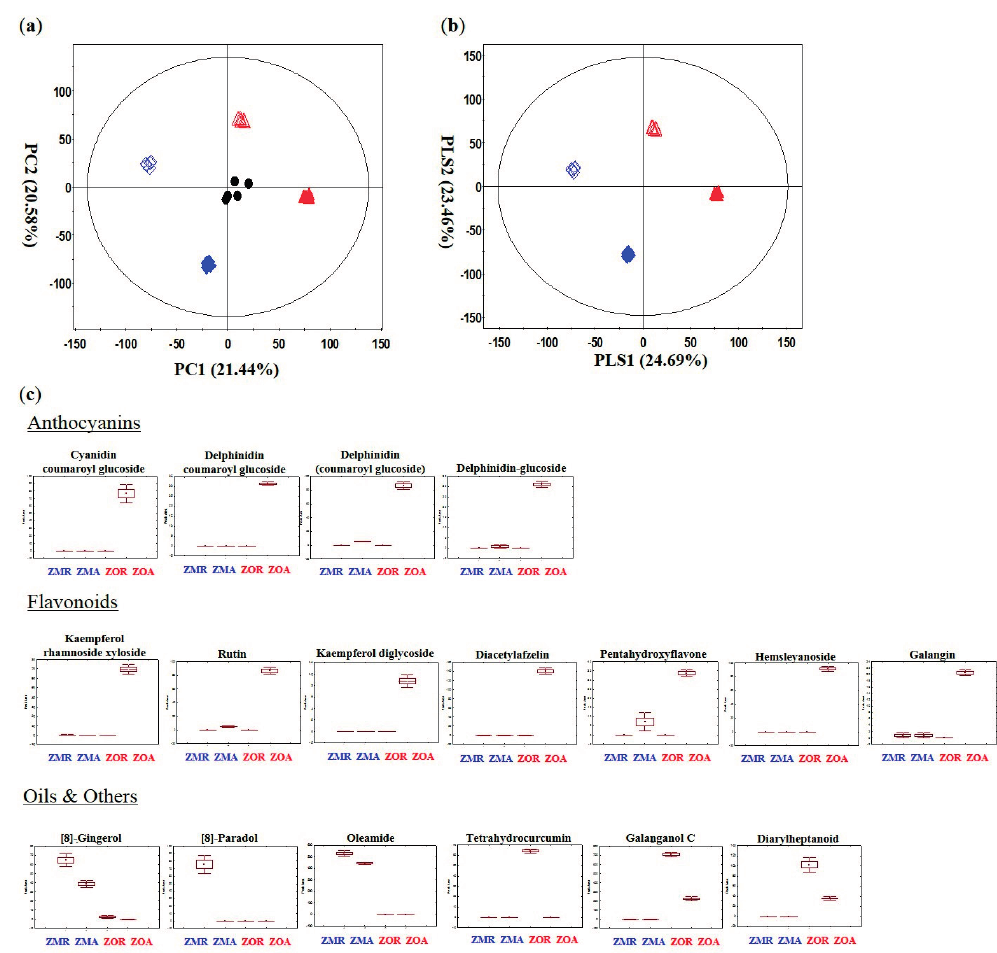
Figure 2. Principal component analysis score plot (PCA) ( a ), Partial least-squares discriminant analysis (PLS-DA) ( b ), and box whisker plot ( c ) of Z. officinale and Z. mioga with different parts analyzed by UPLC-Q-TOF-MS. ▲ : ZMR ( Zingiber mioga Thunb. Root part), △ : ZMA ( Zingiber mioga Thunb. Aboveground part), ♦ : ZOR (Z ingiber Officinale Thunb . Root part), ◊ : ZOA ( Zingiber Officinale Thunb. Aboveground part), and ● : Quality